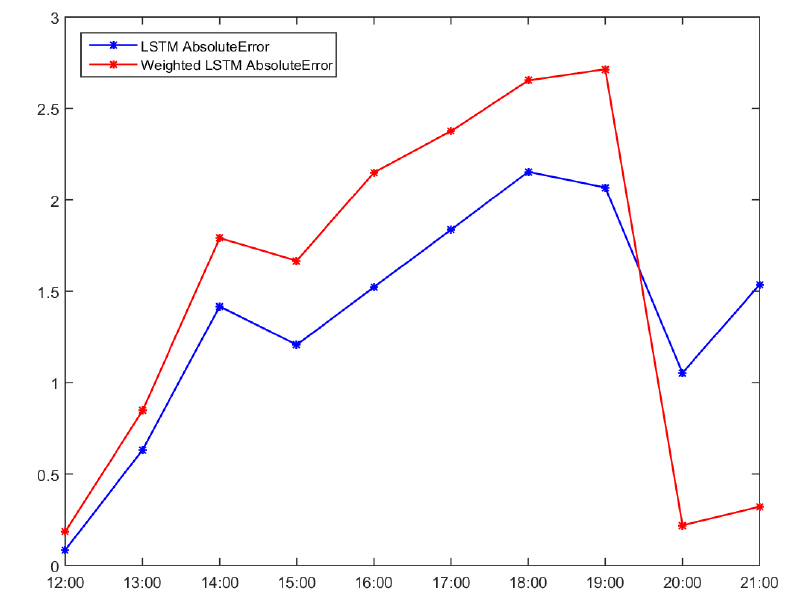
Figure 17. Comparison of errors between the LSTM estimate and weight-applied compensation method and the LSTM estimation-based compensation method.